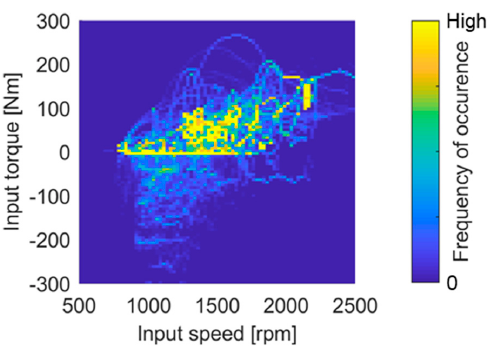
Figure 10. Load spectrum of the transmission input torque for the hybrid drivetrain without limitation of the regeneration torque in the WLTC. Scaling of the color bar identical to Figure 8.